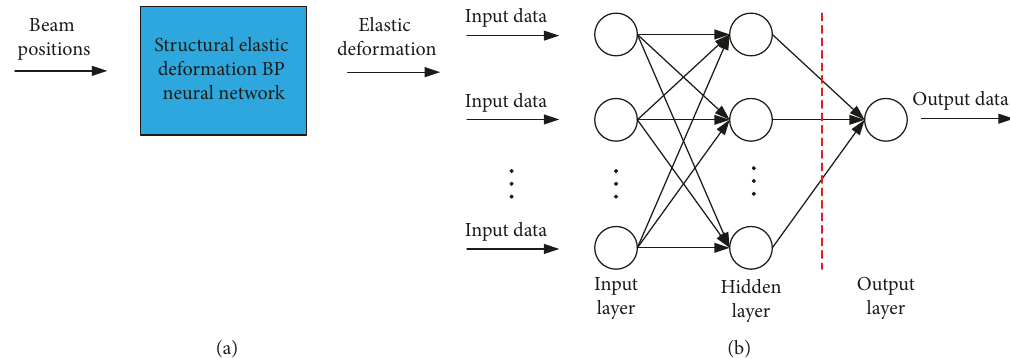
Figure 8: BP neural network prediction model for structural elastic deformation. (a) Input and output parameters of BP neural network model. (b) BP neural network model structure.